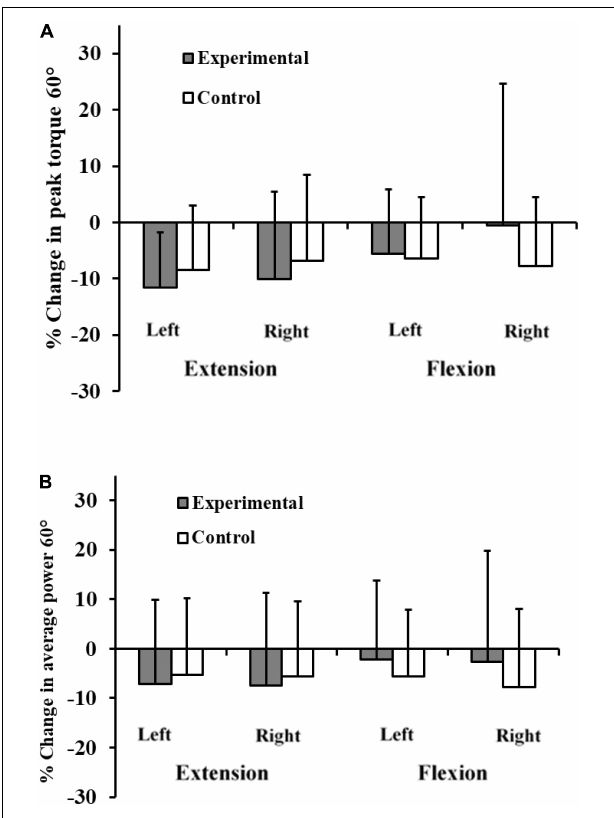
FIGURE 5 | Percentage change in peak torque 60 ◦ (A) and average power (B) for experimental and control subjects after participation of experimental subjects in the 8-week plyometric training program.